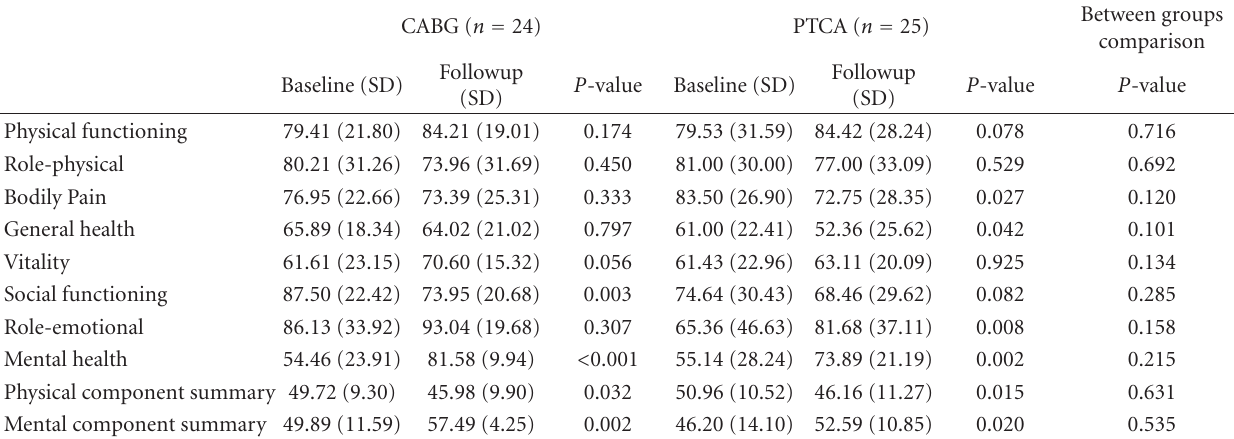
Table 3: The HRQoL scores at the first and third year post-treatment in CABG and PTCA treatment